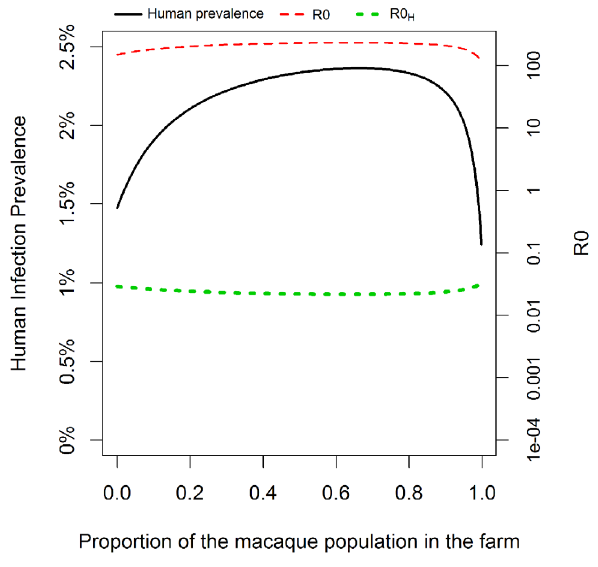
Figure 2. Change in total human infection prevalence, overall R 0 , and human R 0 (R 0H ) with increased human-macaque mixing in the farm